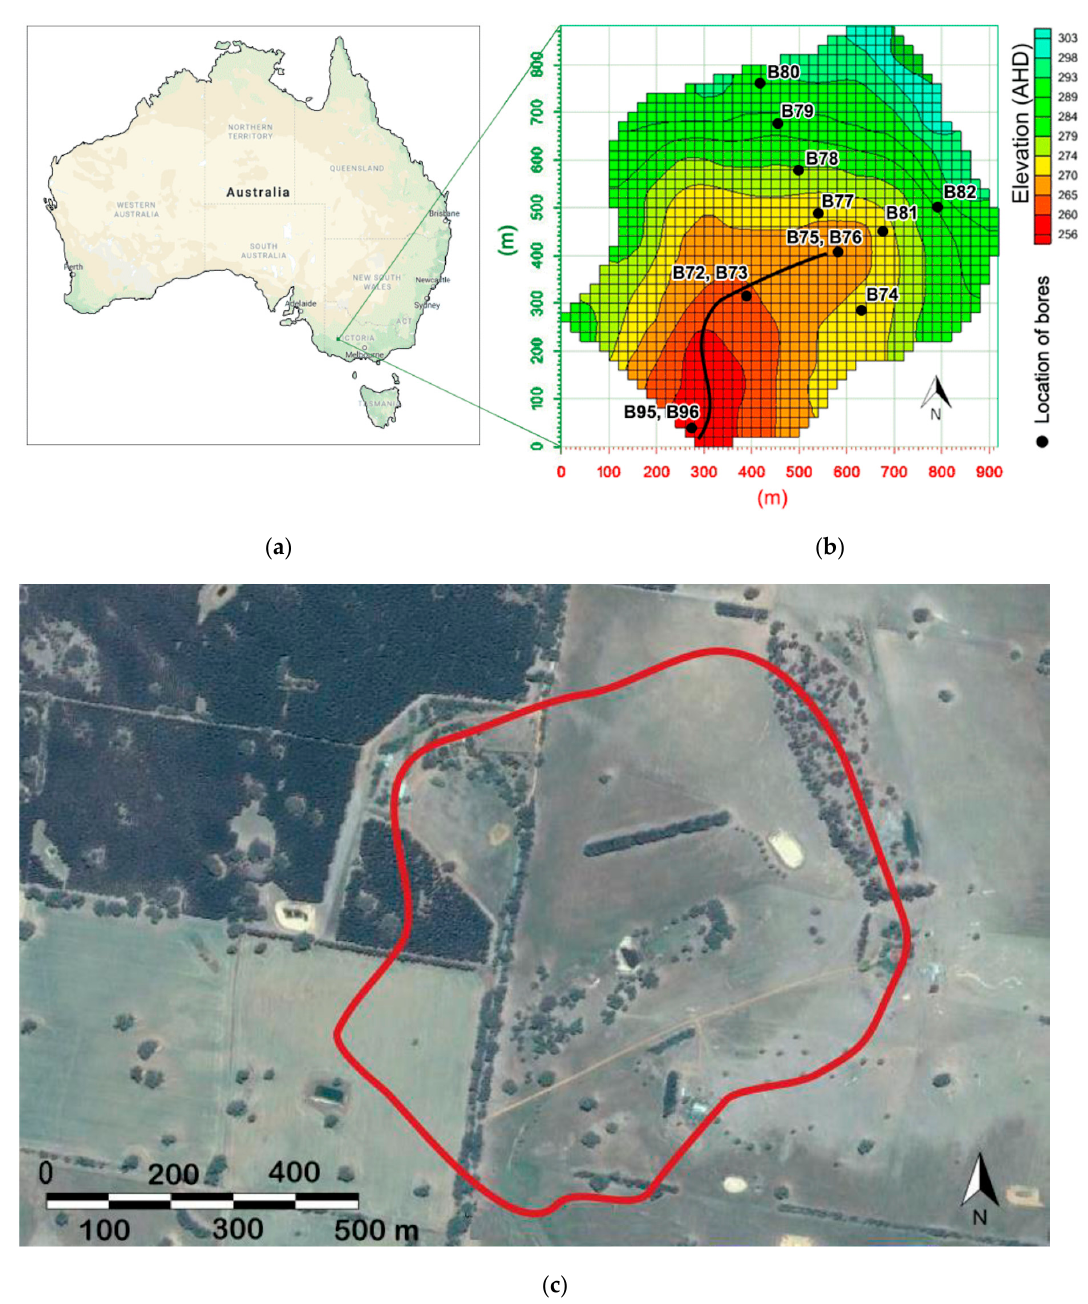
Figure 2. a) Location of the catchment near Mirranatwa in southwestern Victoria, Australia. b) Topography of the catchment, with black dots indicating the locations of groundwater bores and the black lines depicting the creek. c) Catchment boundaries, delineated by the solid red line, and land use (sourced from Google Earth).